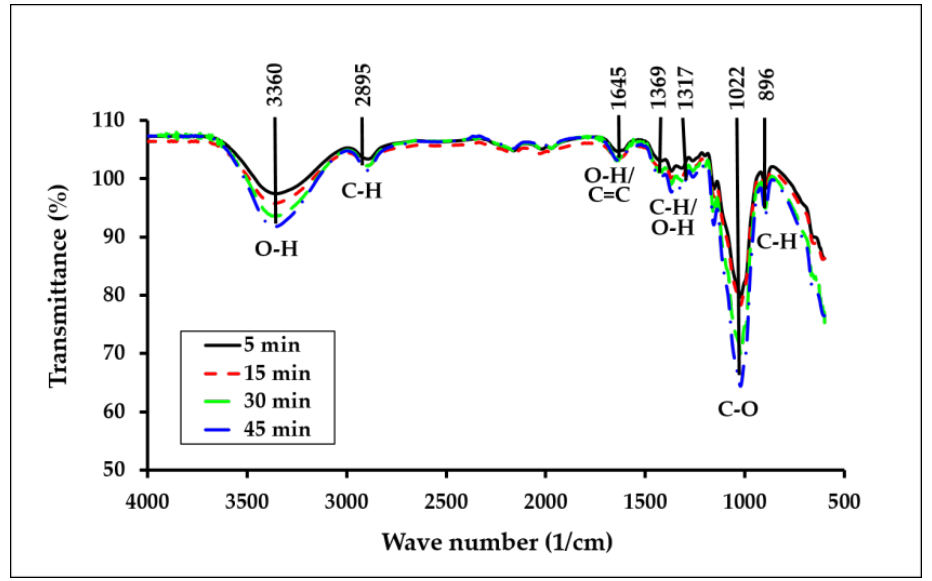
Figure 3. FTIR spectra of the ACCs film composites at different dissolution time. Table 3. Characteristic FTIR peaks and corresponding motions of organic